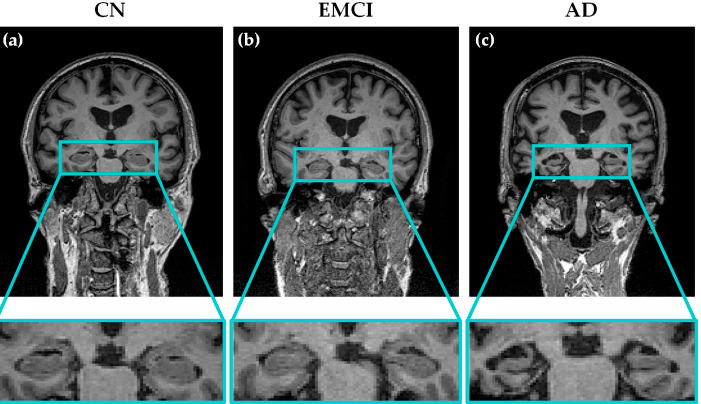
Figure 1 . Examples of T1-weighted coronal MRI scans of three different subjects from the three groups of patients considered in this study: ( a ) cognitive normal (CN); ( b ) early mild cognitive impairment (EMCI) and ( c ) Alzheimer’s disease (AD). The progressive atrophy in the hippocampal region through the different stages of the disease can be